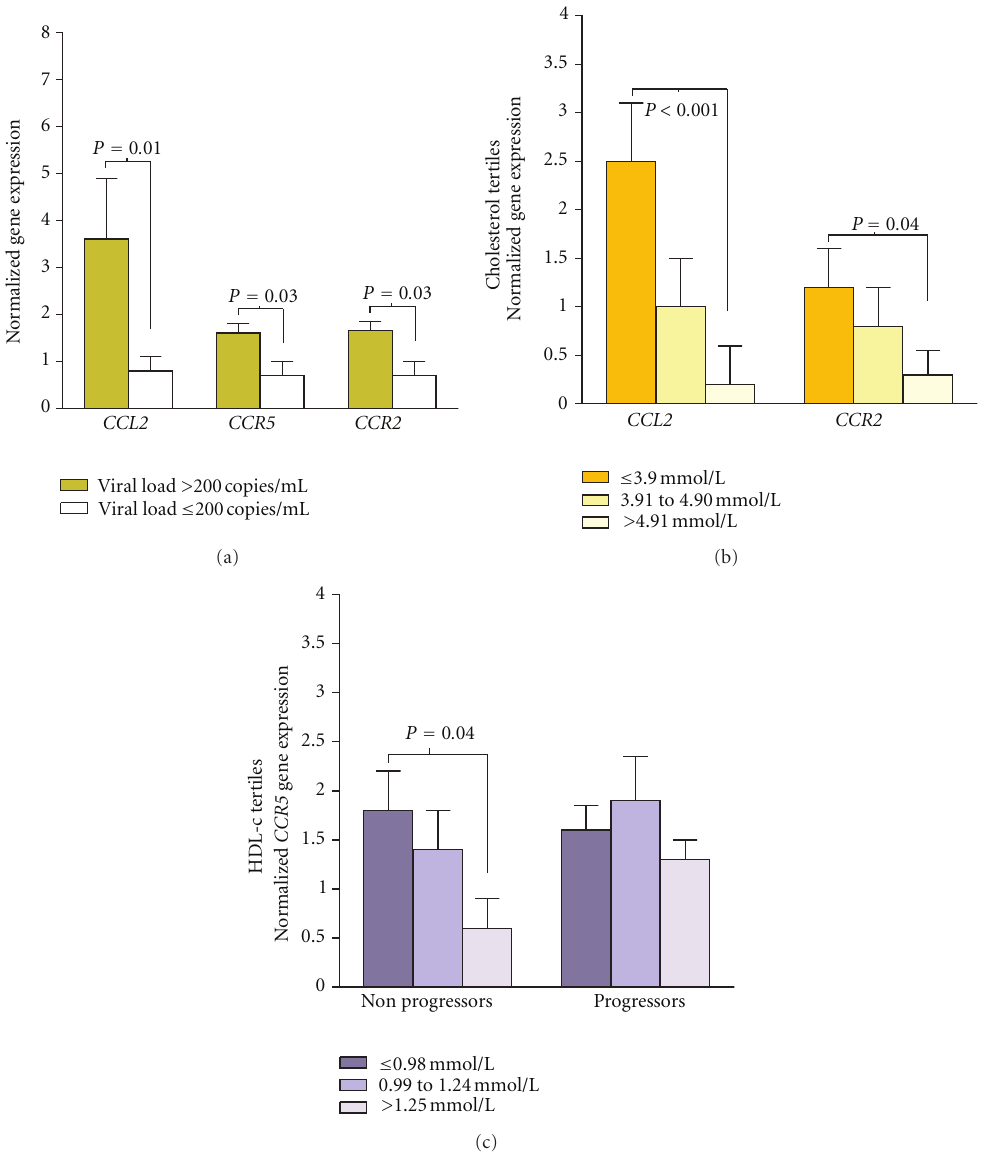
Figure 3: Changes in the expression levels of CCL2 , CCR2, and CCR5 genes. The expression levels of selected cytokine-related genes in blood cells of HIV-infected patients in relation to HIV viral load (a), total cholesterol levels (b), and HDL-cholesterol (HDL-c) concentration